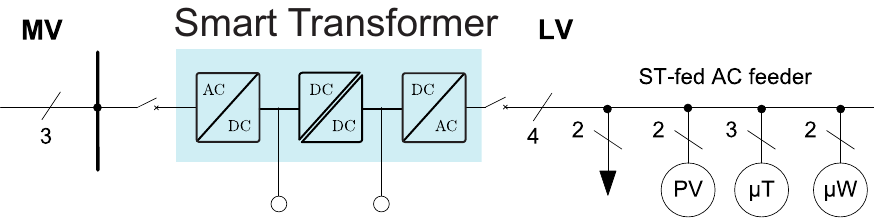
Figure 1. Smart transformer (ST) concept. LV: low voltage; MV: medium voltage; PV: photovoltaic; µ T: micro-turbine; µ W: micro-wind